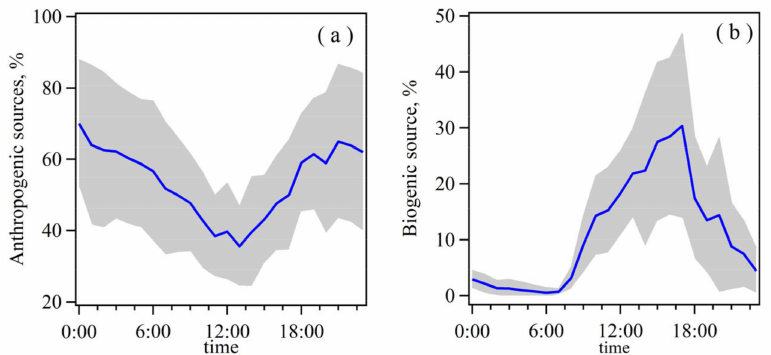
Figure 8. Average diurnal variation patterns of relative contributions from ( a ) anthropogenic sources and ( b ) biogenic source to NMHCs mass